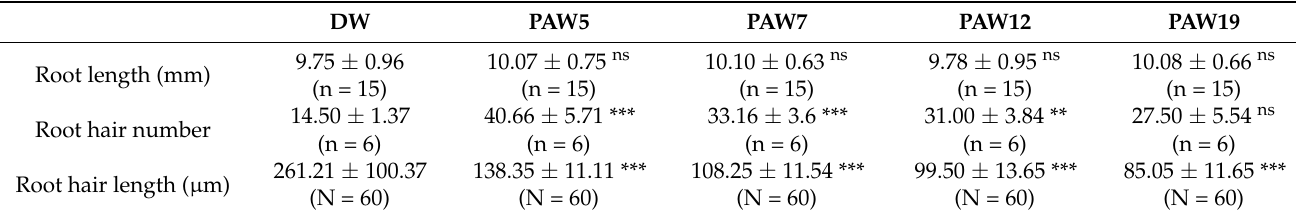
Table 4. Root hair number and length of Arabidopsis ( WER::GFP / cobl9-1 ) at 5 days after planting.